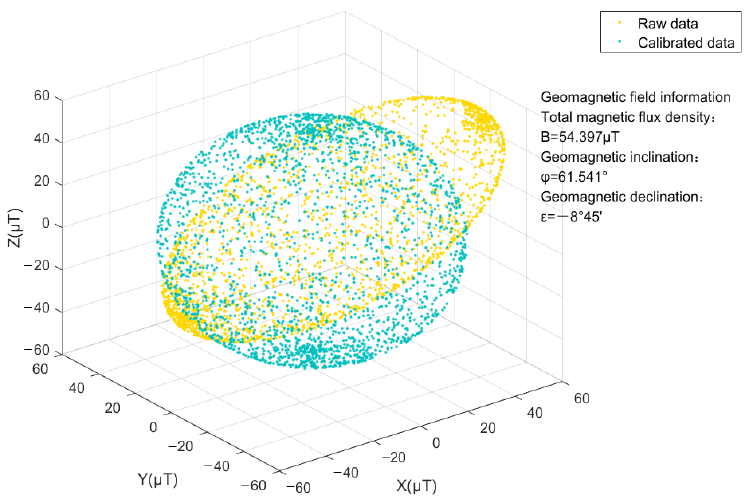
Figure 2. Tri-axis magnetic field distribution.